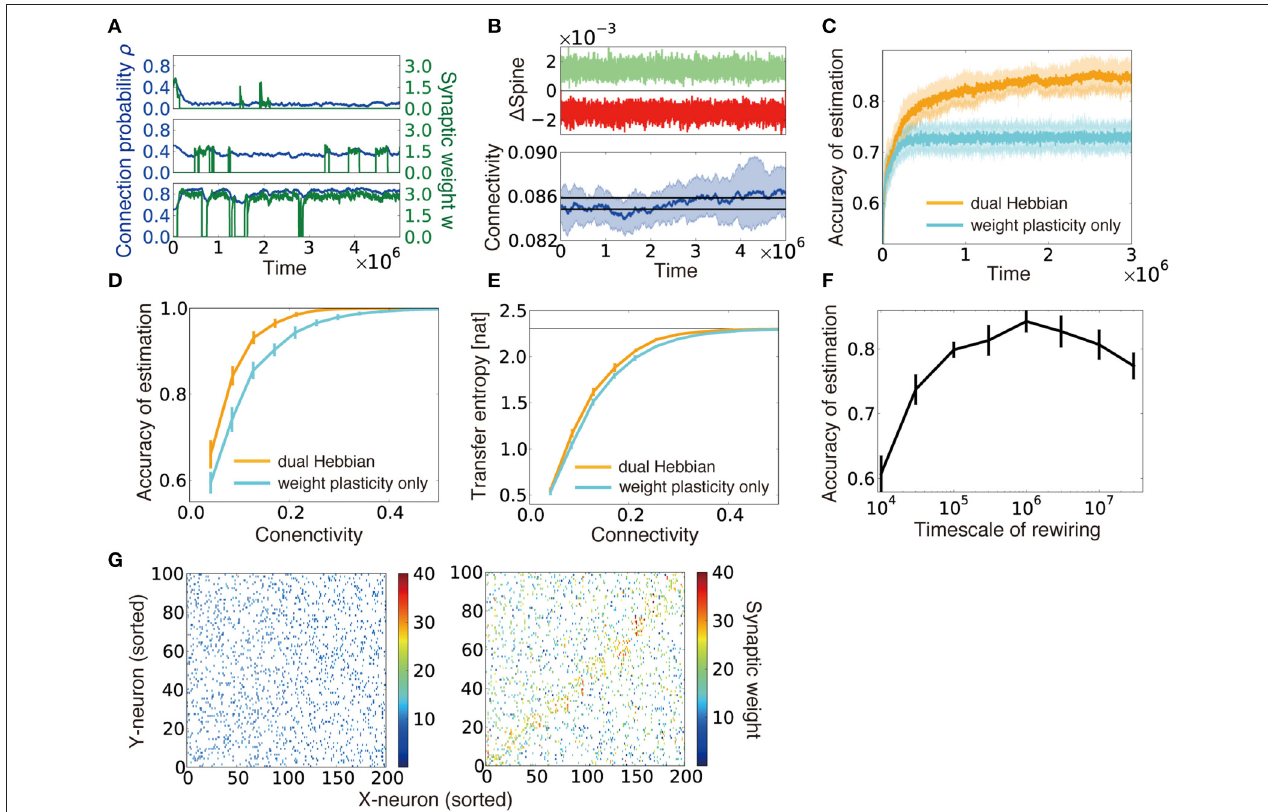
FIGURE 5 | Dual Hebbian learning for synaptic weights and connections. (A) Examples of spine creation and elimination. In all three panels, green lines show synaptic weights, and blue lines are connection probability. When there is not a synaptic connection between two neurons, the synaptic weight becomes zero, but the connection probability can take a non-zero value. Simulation was calculated at ρ elimination and creation. Number of spines eliminated (red) and created (green) per unit time was balanced (top). As a result, connectivity did not appreciably change due to rewiring (bottom). Black lines in the bottom graph are the mean connectivity at γ for the model with/without wiring plasticity. For the dual Hebbian model, the sparseness parameter was set as γ plasticity model to perform comparisons at the same connectivity (see B ). (D,E) Comparison of the performance (D) and the maximum estimated transfer entropy (E) after learning between the dual Hebbian model and the model implemented with synaptic plasticity only at various degrees of connectivity. Horizontal line in (E) represents the total information log e p . (F) Accuracy of estimation with various timescales for rewiring τ c . Note that the simulation was performed only for 5 steps, and the performance did not converge for the model with a longer timescale. (G) Synaptic weight matrices before (left) and after (right) learning. Both X-neurons (input neuron) and Y-neurons (output neurons) were sorted based on their preferred external states.